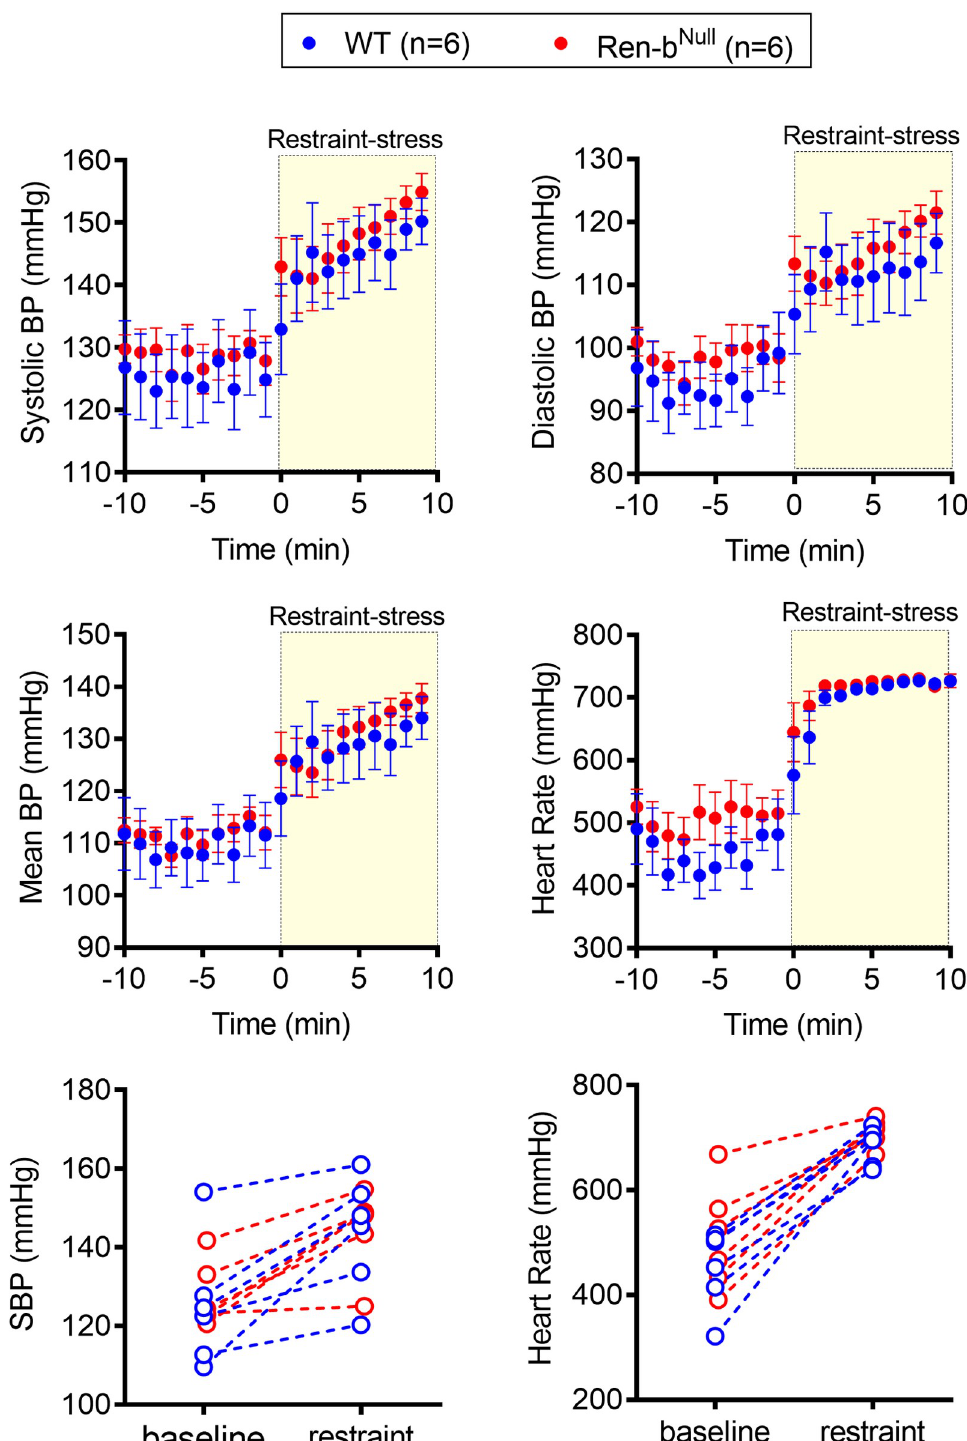
Fig 6. Blood pressure response to restraint stress (LSD). Acute responses to restraint-induced blood pressure (BP) and tachycardia in male Ren-b Null mice and wildtype littermate controls (WT) fed low salt diet. First, telemetric recordings were obtained from low salt diet-fed mice in their home cages at baseline. Following 10 minutes of recording, mice were immediately inserted into an acrylic restrainer and telemetric data were acquired for 10 minutes. One-minute recording was averaged, and the systolic BP, diastolic BP, mean BP, and heart rate (A, B, C, and D, respectively) was expressed as